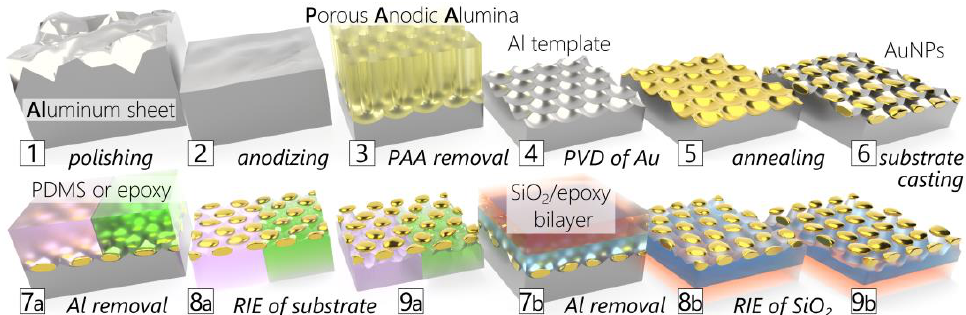
Figure 1. A comprehensive illustration of fabrication technologies towards gold nanoparticle nanocomposites. (1–4) Fabrication of nanobowled aluminum templated for controlled synthesis of gold nanoparticles (AuNPs) by (4–6) a solid-state dewetting (SSD) of the thin gold film. (6–8) Transfer of AuNPs on various substrates and (8–9) their exposure by reactive ion etching (RIE) of substrates. Three generations of nanocomposites are compared in this work using (7a–9a) PDMS, epoxy, and (7b–9b) SiO 2 as a substrate.